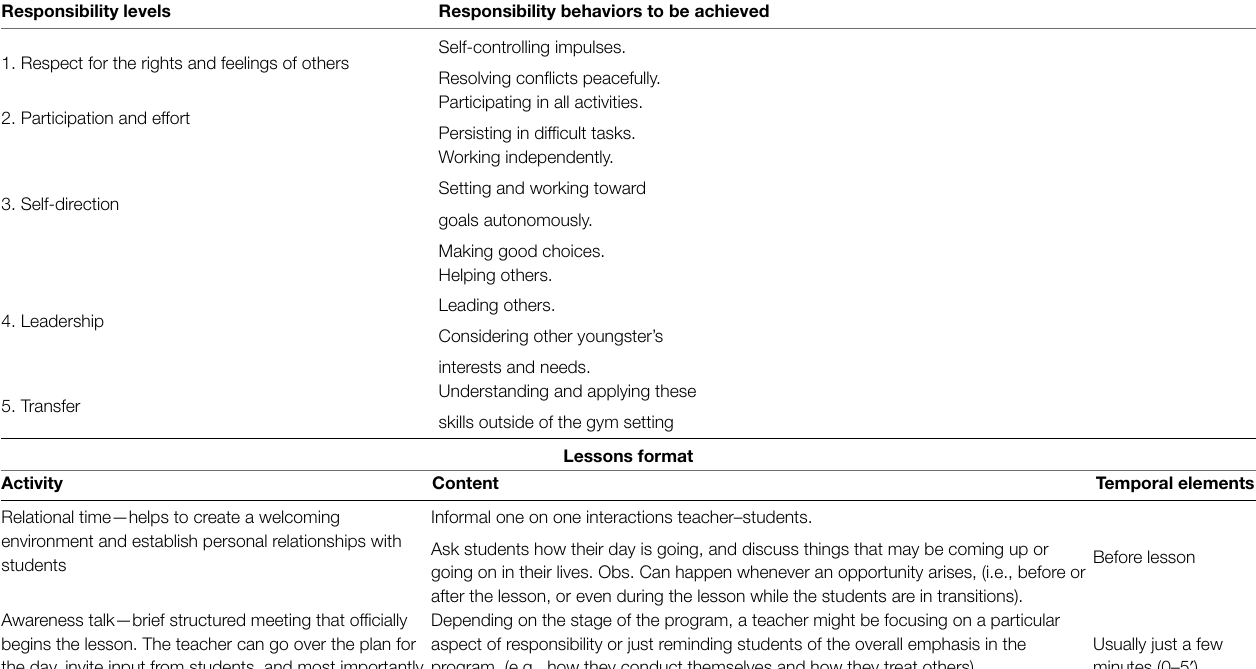
TABLE 1 | Levels of responsibility, core behaviors, sessions, and format lessons during the intervention. Responsibility